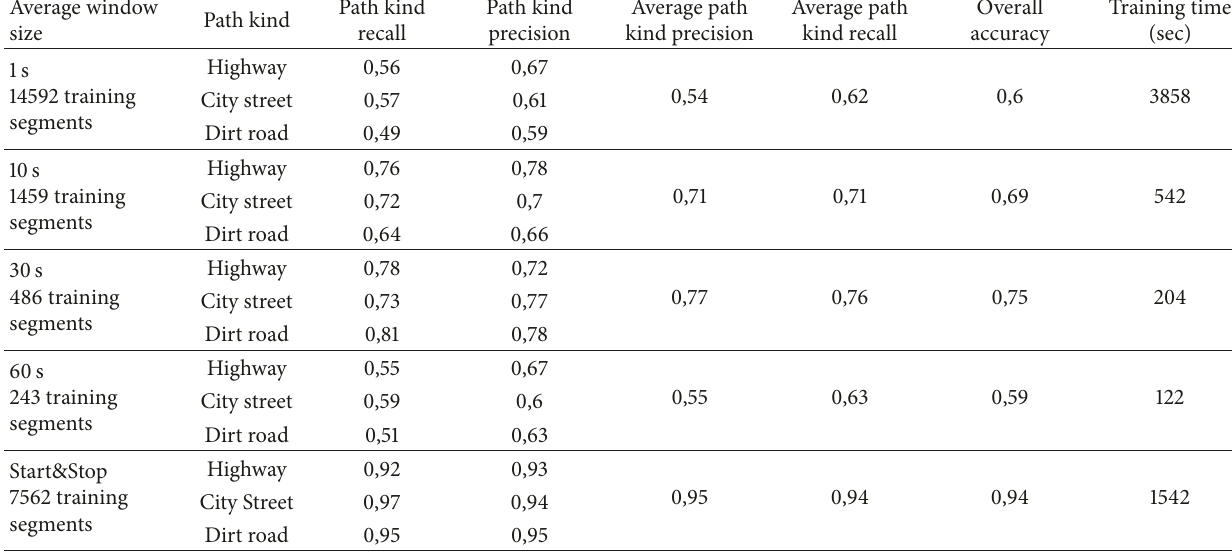
Table 9: 𝐸 2 , precision, recall, accuracy, and training time evaluated by using MLP for different windows sizes. Average window